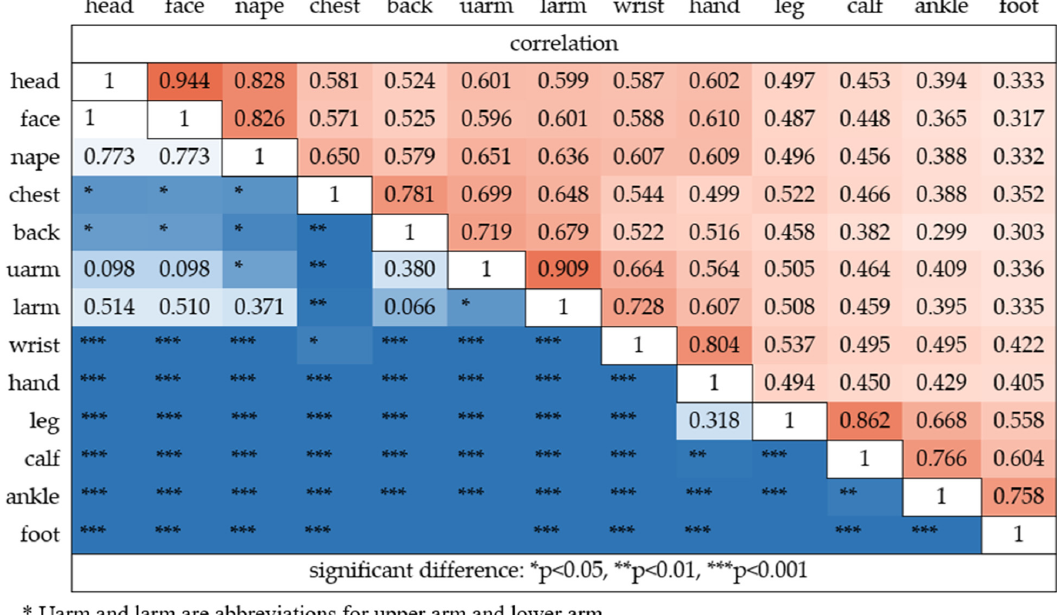
Figure 7. The correlations and significant differences between the thermal preferences of the 13 body parts.